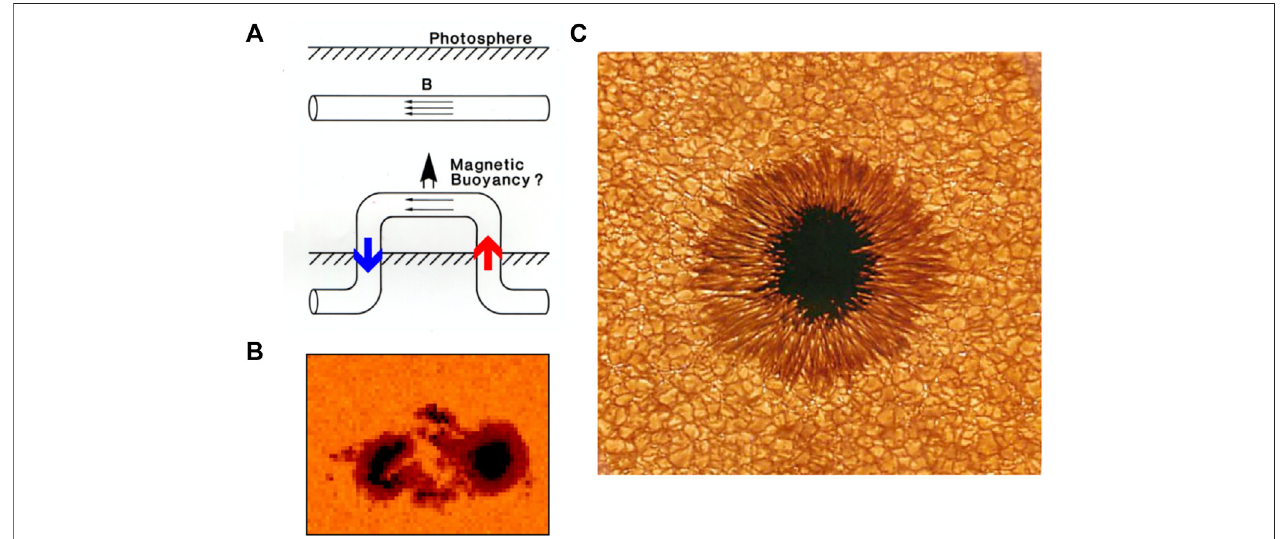
FIGURE 3 | (A) A schematic illustration of Babcock ’ s theory of a pair of sunspots. (B) A typical example of a pair of sunspots (Courtesy of the Kitt Peak Solar Observatory). (C) A typical example of single spots (Courtesy of The Kitt Peak Solar Observatory and the NASA Sunspot